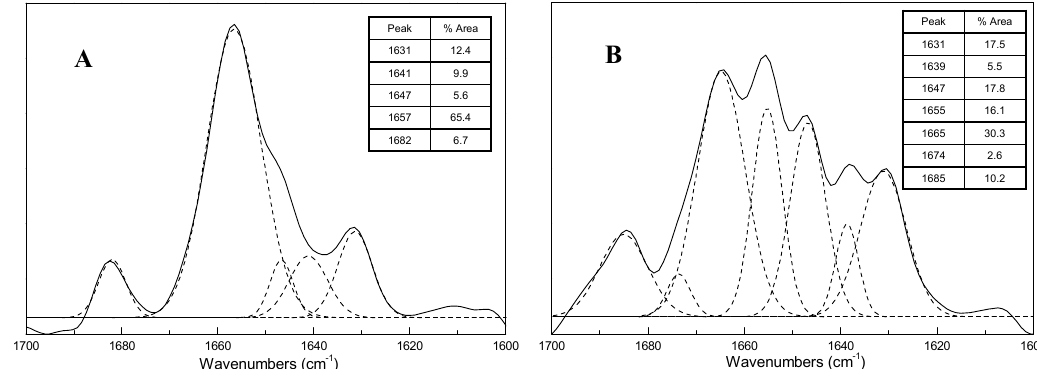
Figure 3. Fourier self-deconvolved infrared spectra in the amide I region of ICFs ( A ) and PSCs ( B ) obtained at 5 °C with the resolved underlying bands as deduced through peak-fitting analysis (5% w / v in D 2 O). The accompanying tables list the positions and relative percent areas of these components.